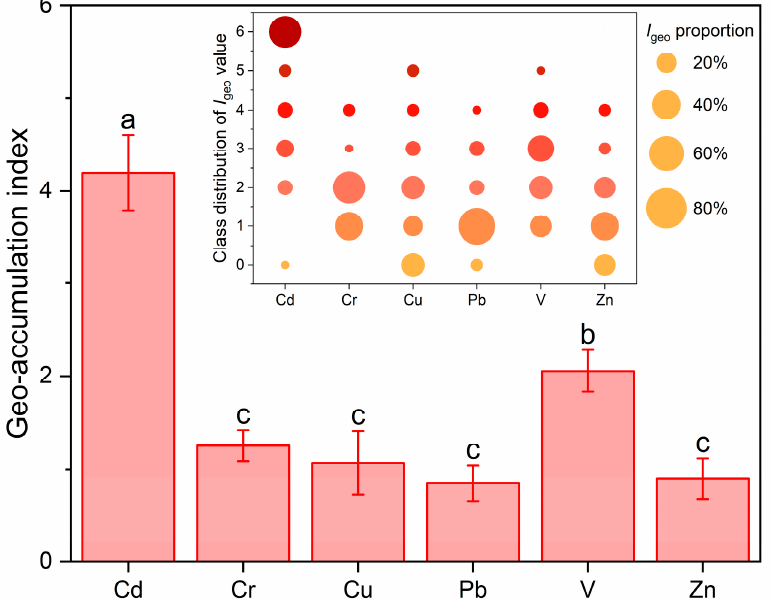
Figure 2. The I geo values and proportions of trace metals in agricultural soils around the V-containing stone coal smelting site. Values followed by different lowercase letters are significantly different at α = 0.05.